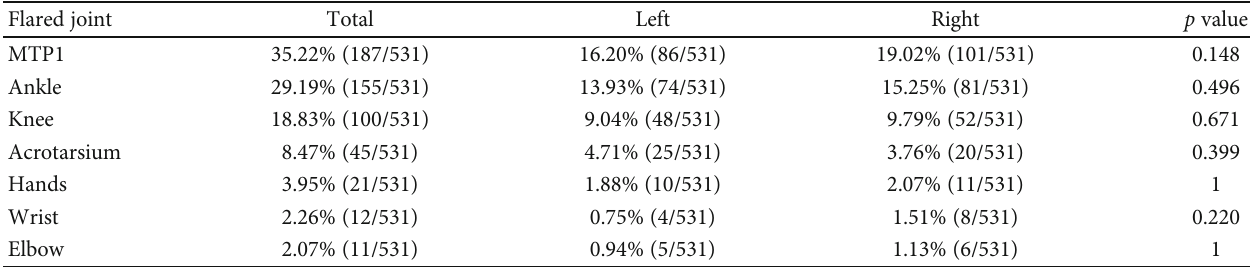
Table 2: Clinical characteristics of gouty attacks in the gout population.